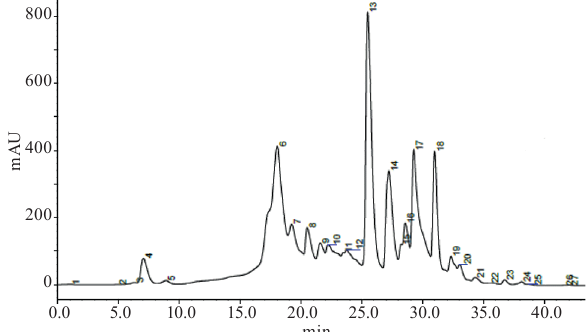
Figure 3 Chromatogram of ethanol extract from roots of Scutellaria galericulata L.